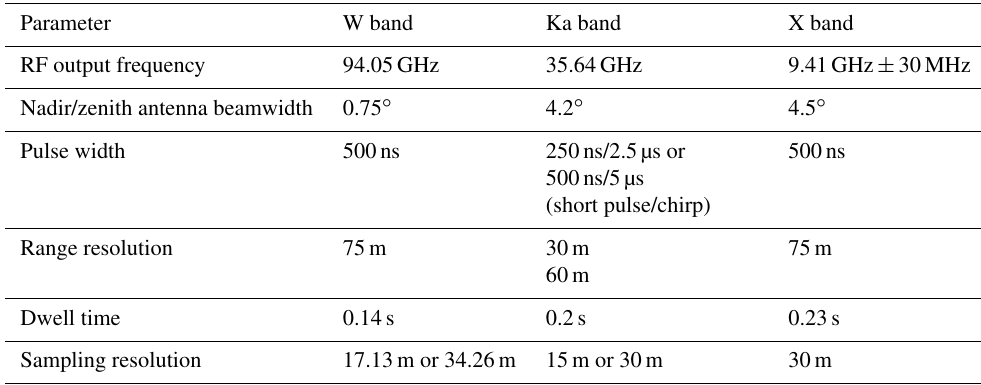
Figure 1. Example of DFR Ka/W vs. DFR X/Ka corresponding to different populations of snow habits with different characteristic diameters of PSD. The habits correspond to state-of-the-art scattering models: the first habit is a mixture of aggregates from the database described in Kuo et al. (2016); the next 14 habits are extracted from the ARTS scattering database (Eriksson et al., 2018); the last three habits are from the models of Leinonen and Szyrmer (2015). For the first two classes of models, scattering properties are computed via discrete dipole approximation for gamma PSD with the shape parameter µ equal − 2, 0, and 8 (same symbols); for the last class the self-similar Rayleigh– Gans approximation (for the corresponding coefficients see details in Mróz et al., 2021a) is used with exponential PSDs. The characteristic mean mass-weighted maximum size of the particle size distribution increases with the curve moving out from the origin (that corresponds to Rayleigh particles with all DFRs being equal to zero). For each line the thick filled circle, triangle, and square markers represent values of D m equal to 2, 4, and 6mm, respectively. Table 1. Radar parameters for the RadSnowExp